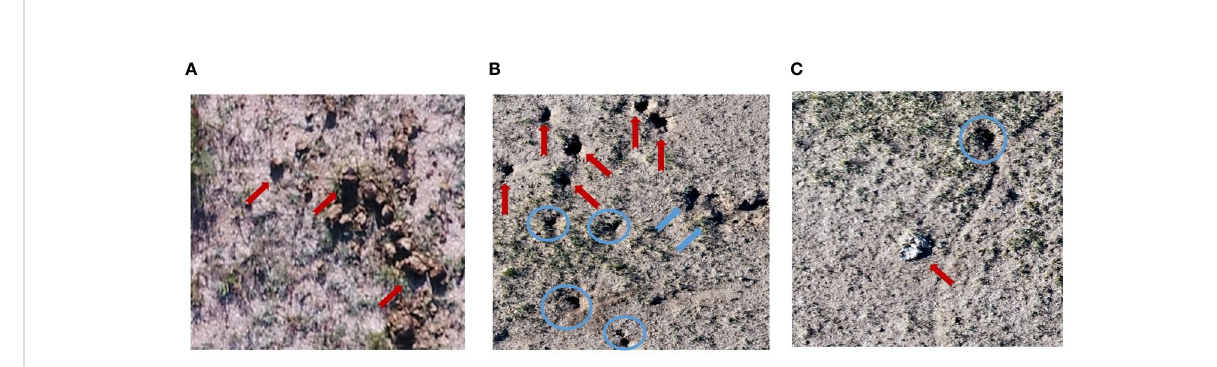
FIGURE 7 Noises in detection in a typical steppe ecosystem are pointed out using red arrows. (A) Animal droppings, (B) hoofprints (red arrows) and shadows of grass (blue arrows), (C) shadows of rock. Actual BV holes are in blue